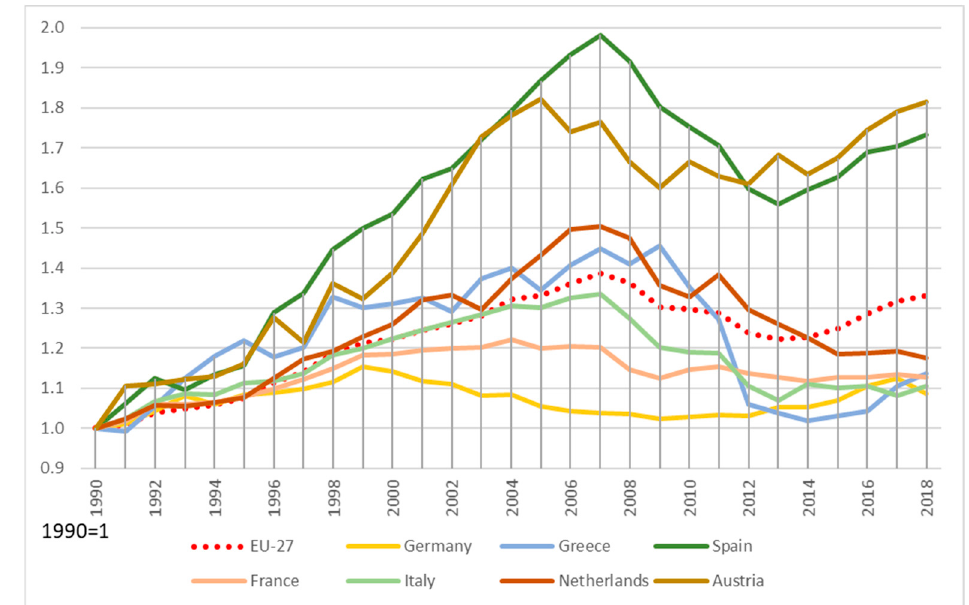
Figure 1. Development of CO 2 emissions from transport in selected EU countries [4].